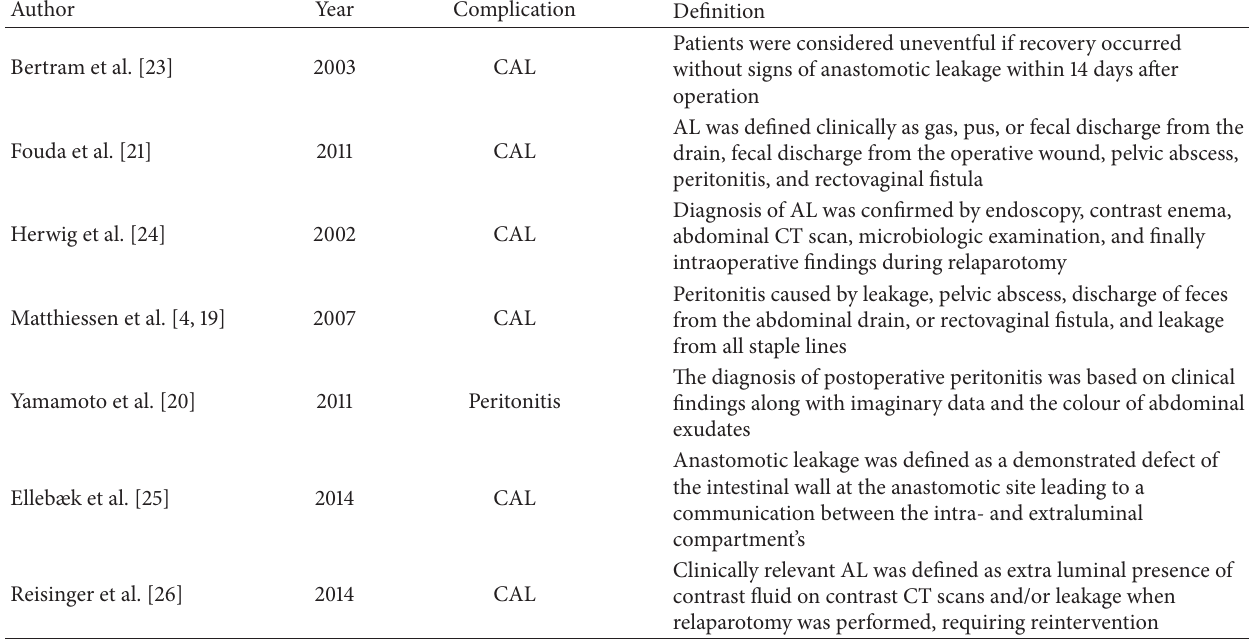
Table 3: Definition of anastomotic leakage of included studies; CAL: colorectal anastomotic